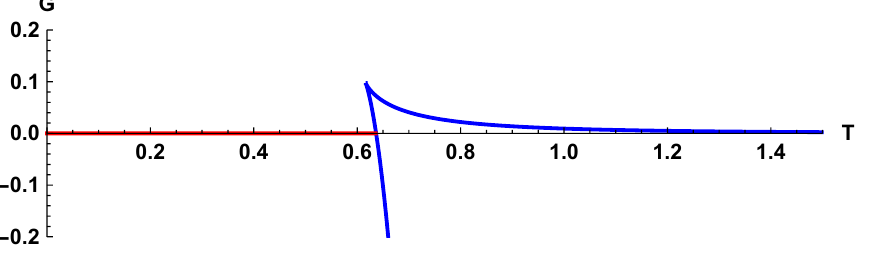
Figure 3 . The AdS-Schwarzschild phase diagram. The Gibbs free energy G vs. the temperature T . The upper branch of the phase diagram is referred to as the small black hole branch and the lower branch is referred to as the large black hole branch. The two branches meet at the cusp ( T min , G max ) ≈ (0 . 616 , 0 . 097) . The red line G = 0 in the range 0 < T < T HP represents the thermal AdS gas. The large black holes are thermodynamically preferred for T > T HP ≈ 0 . 636